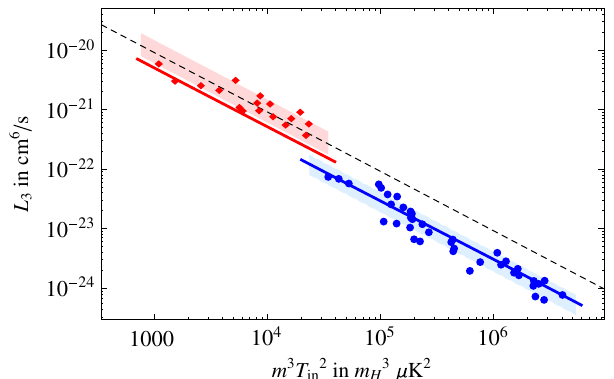
FIG. 3. The magnitude of three-body loss rate at unitarity for 7 Li (red) and 133 Cs (blue), with the respective standard deviations (shaded areas). On the horizontal axis, masses are scaled to the hydrogen atom mass m . The dashed line represents the unitary H → ∞ ]. For comparison, we show predic- limit [Eq. (3) with η (cid:1) tions of universal theory [15] with η ¼ 0 . 21 for 7 Li [28] and (cid:1) η ¼ 0 . 098 ð 7 Þ for 133 Cs as solid lines (see text). The data confirm (cid:1) the universality of the L 3 ∝ T − 2